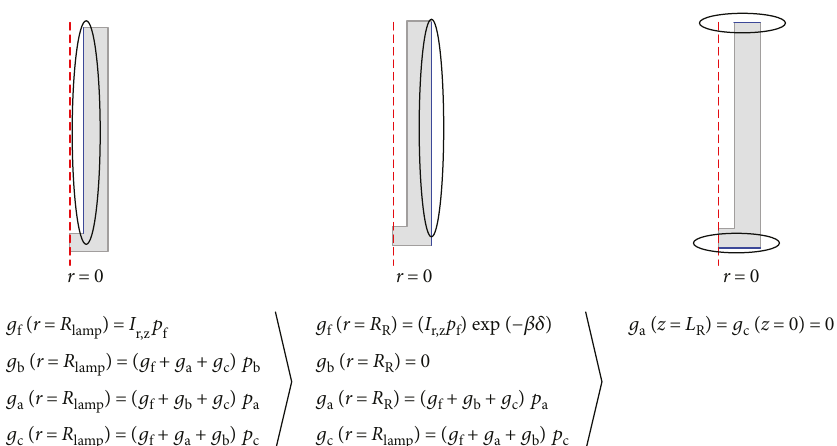
Figure 3: Boundary conditions used in the four- fl ux